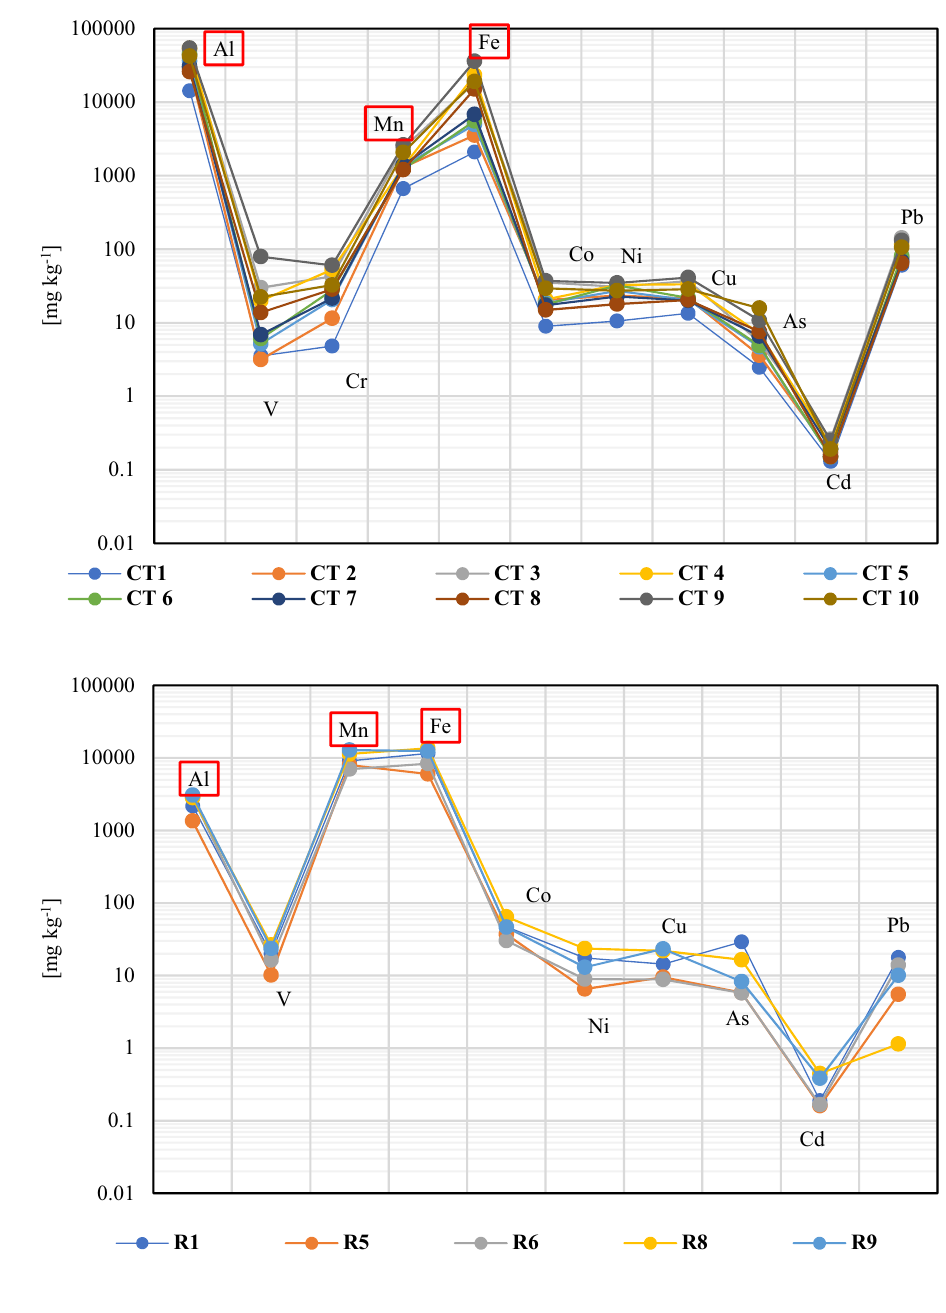
Table 1 Geoaccumulation index ( I ) for Rainer and geo Femar